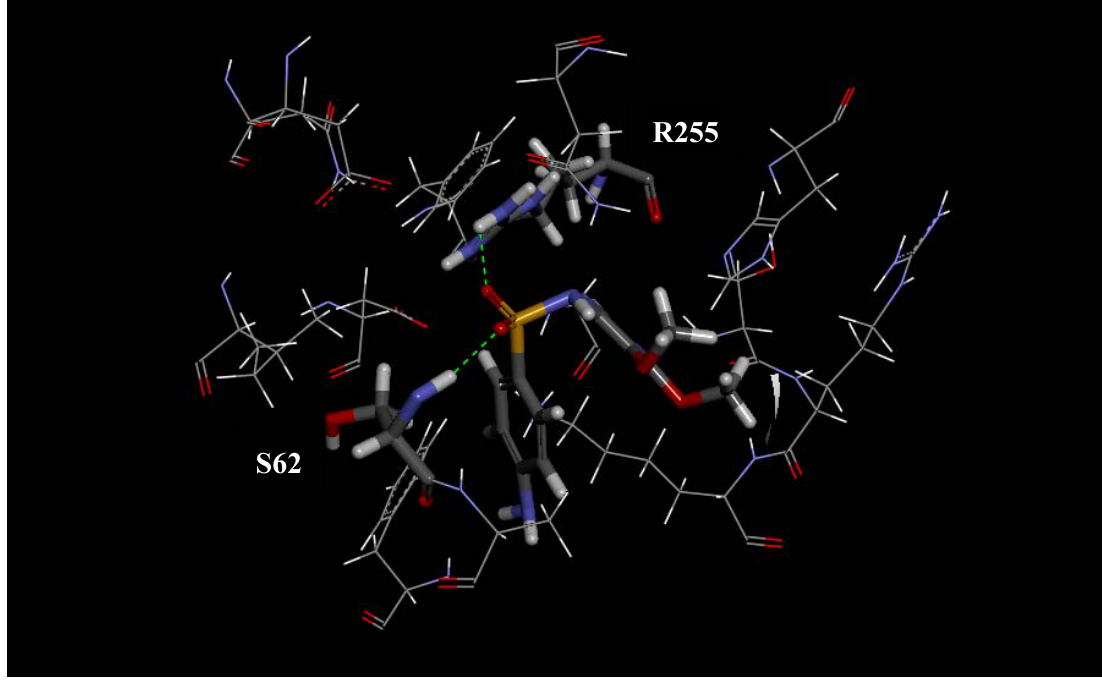
Figure 3. Docking of sufadoxine into P. falciparum DHPS.